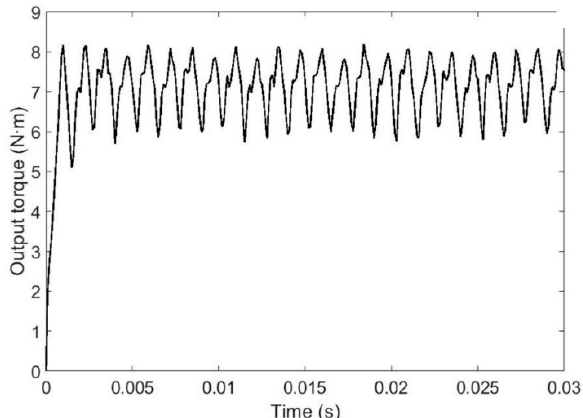
Figure 2. 2-D cross-section of the BLDC motor.